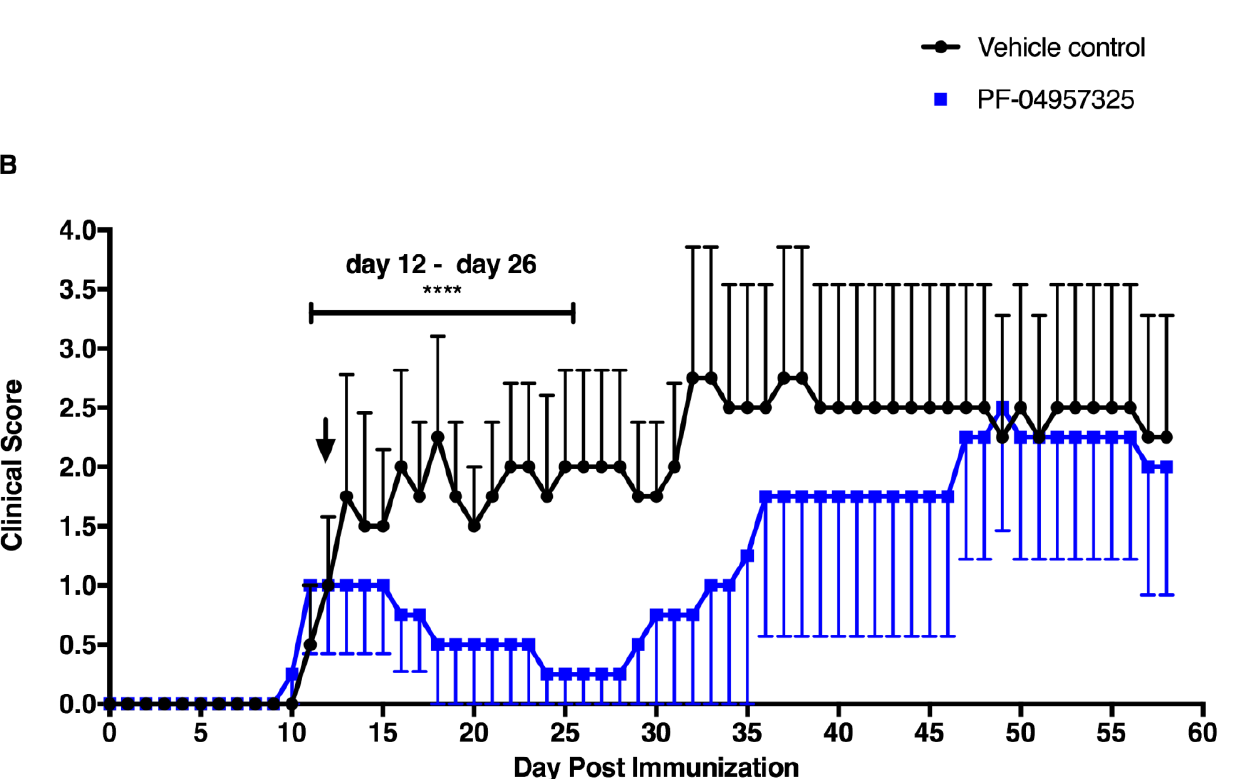
Figure 1. Treatment with the PDE8 inhibitor PF-04957325 treats clinical signs of EAE in a therapeutic manner. ( A ) C57BL/6 mice with an EAE score of at least 1 were treated with the vehicle control in an equivalent volume of DMSO and PBS to the corresponding inhibitor dose (vehicle control), or PF-04957325 (10 mg/kg/dose diluted in DMSO and PBS) subcutaneously 3 times per day, from day 13 to day 22, as indicated by the bar in the figure. The arrow indicates the day on which the treatments were initiated. The data represent the mean clinical scores (mean ± SEM) for each day ( n = 6 mice per group) *** p = 0.0007. ( B ) C57BL/6 EAE mice were implanted with Alzet mini-osmotic pumps filled with either the vehicle alone (50% DMSO and 50% PBS) or PF-04957325 (with a continuous release rate of 15.5 mg/kg/day) in a vehicle on day 12 post-immunization. The treatment duration based on the physical properties of the pumps was 14 days, as indicated by the bar in the figure. The arrow indicates the day on which the treatments were initiated. The data represent the mean clinical scores (mean ± SEM) for each day ( n = four mice per group) **** p < 0.0001.